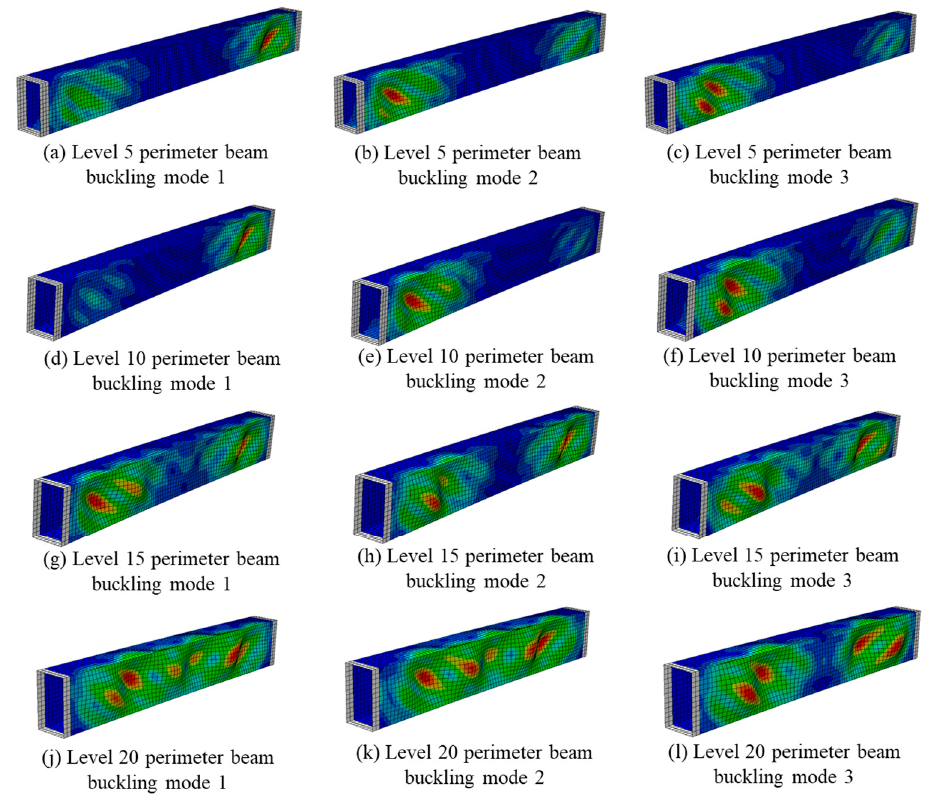
Figure 25. The buckling shapes of different modes of each curved beam.